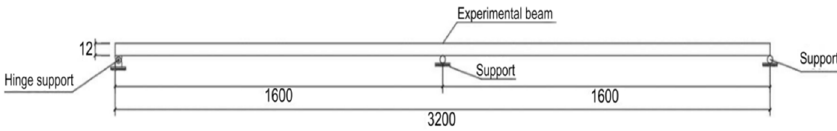
Figure 28. Schematic diagram of case model. Table 7. Working conditions of the case.